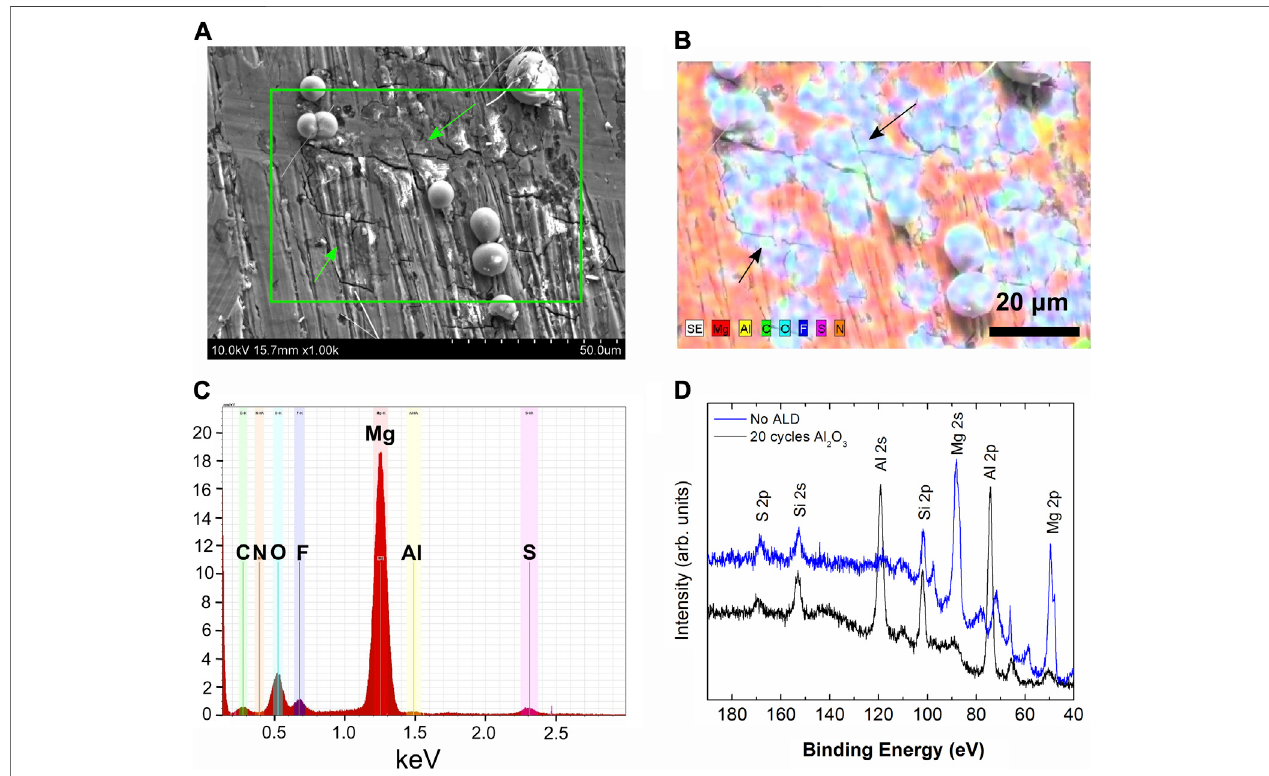
FIGURE 7 | Analysis of a cycled Mg foil electrode with 2 nm Al 2 O 3 (A) SEM image showing Mg deposits and stripping regions, with stripped regions indicated by green arrows (B) EDS map of the region in the green box from (A) with stripped regions indicated with black arrows (C) EDS spectrum corresponding to the map in (B) , and (D) XPS spectrum of the low binding energy region containing Mg and Al signals taken using a non-monochromatic Mg x-ray source.